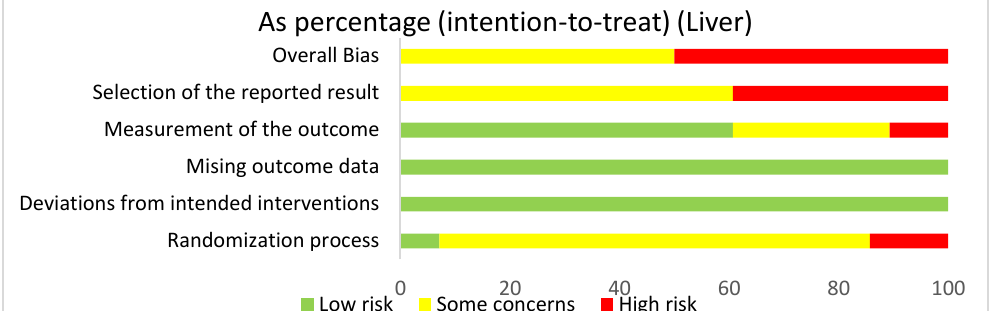
Figure 6. The overall bias for all the studies regarding the liver was a high risk of bias (50%) and some concerns (50%). The selection of the reported result had a high risk of bias (39.3%) and some concerns (60.7%). The measurement of the outcome had a low risk of bias (60.7%), some concerns (28.6%), and high risk of bias (10.7%). The missing outcome data and the deviations from intended interventions domain had a low risk of bias of 100%. The randomization process had a high risk of bias (14.3%), some concerns (78.6%), and low risk of bias (7.1%).